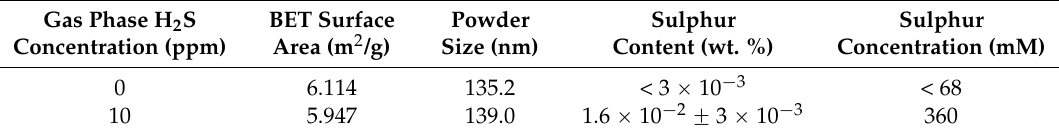
Figure 7. Scanning Transmission electron—angular dark field (STEM-ADF) micrographs and corresponding EDS elemental maps of a model-composite Pt/GDC 20 electrode, which was sulphur enriched by cathodic polarisation (see Figure 6). The gold and tungsten layers were applied as a protective cover during TEM preparation. ( a ) STEM-ADF micrograph of the GDC 20 layer away from Pt current collectors, the dotted areas correspond roughly to sulphur enriched zones; ( b ) EDS elemental maps of the investigated area in ( a ), the bright green areas in the GDC layer correspond to sulphur enriched regions; ( c ) Quantitative map (wt. %) of sulphur enriched regions in the part of the GDC layer imaged in ( a , b ); ( d ) STEM-ADF micrograph of the GDC 20 layer close to the Pt current collector and corresponding EDS elemental map in ( e ) and quantitative map of sulphur in ( f ), respectively. Table 3. Specific BET surface areas, powder sizes and sulphur content of GDC 10 powder samples treated for 72 h at 750 °C in a wet 2.5% vol H 2 in Ar atmosphere, with a ratio of hydrogen to water of 1:1. The powder size was calculated from the surface area by assuming equally sized spheres. The volumetric sulphur concentration assumes homogeneously distributed sulphur in the GDC bulk.